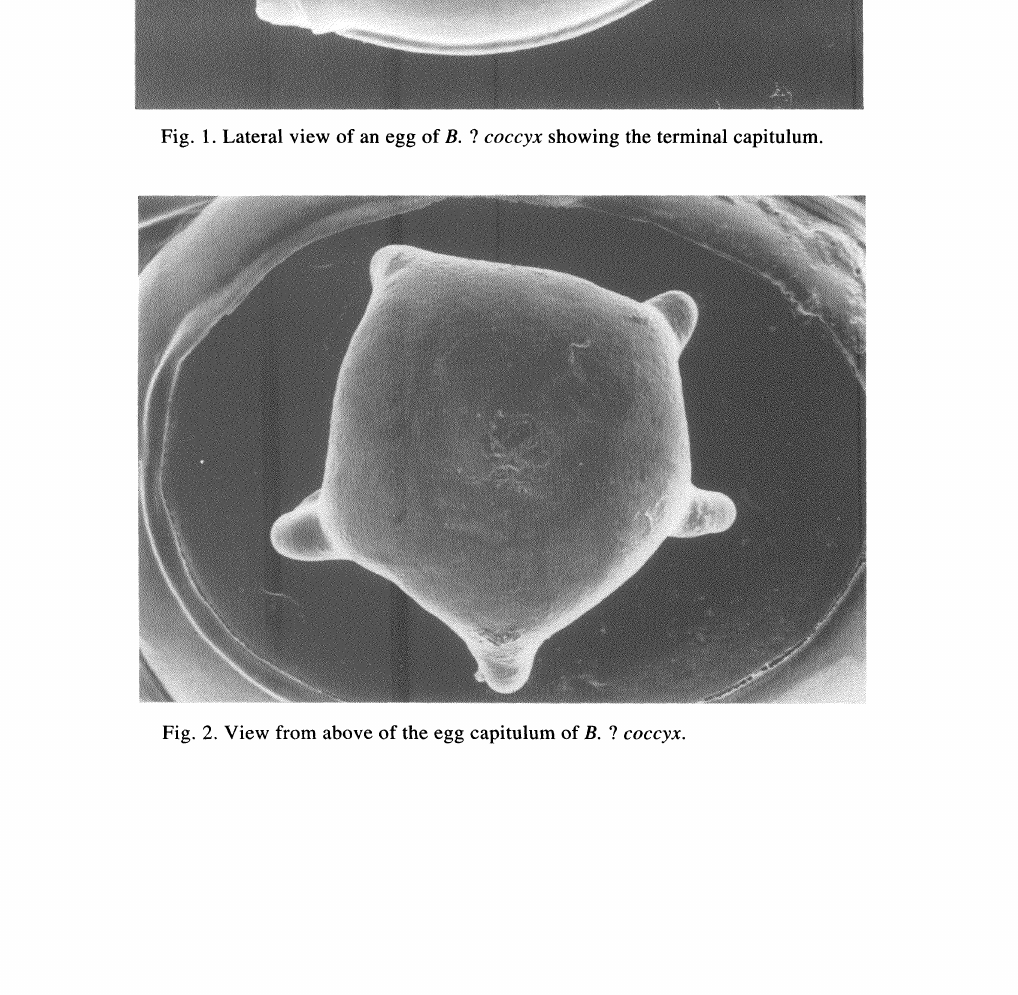
Fig. 2. View from above of the egg capitulum of B. ?